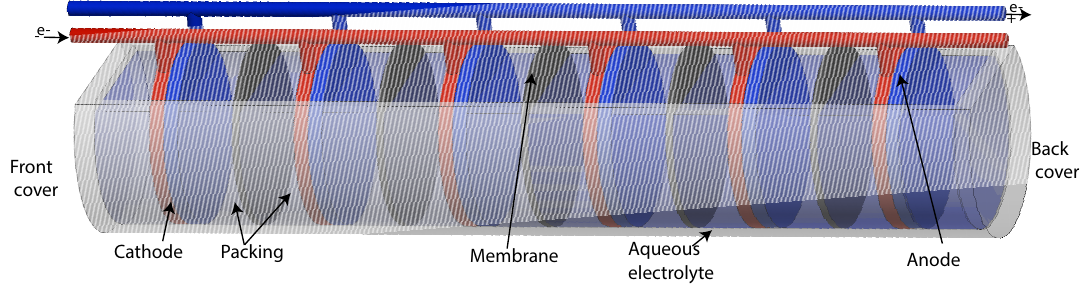
Figure 1. Principle of a bipolar electrolyzer design.